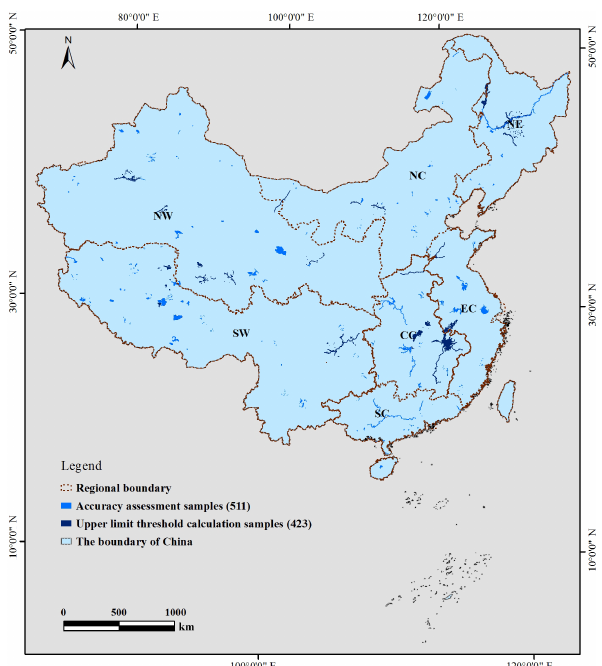
Figure 2. The boundary of China, the accuracy assessment and the upper-limit threshold calculation samples for surface water ex- traction. NW: Northwest China, SW: Southwest China, SC: South China, CC: Central China; NC: North China, NE: Northeast China, EC: East China.